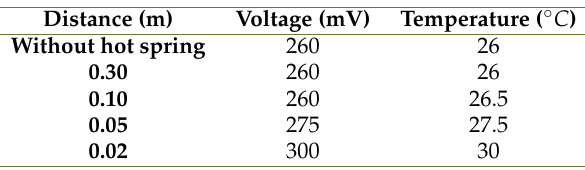
Table 3. Variation of voltage according to the distance